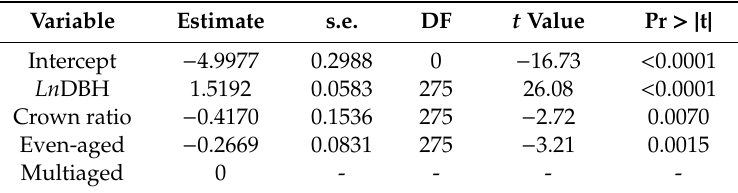
Table 10. Bark thickness (BT) model for redwood trees in even-aged stands and understory trees in multiaged stands. Generalized linear model for natural log ( Ln )-transformed BT (mm) as a function of DBH (mm) and crown ratio.